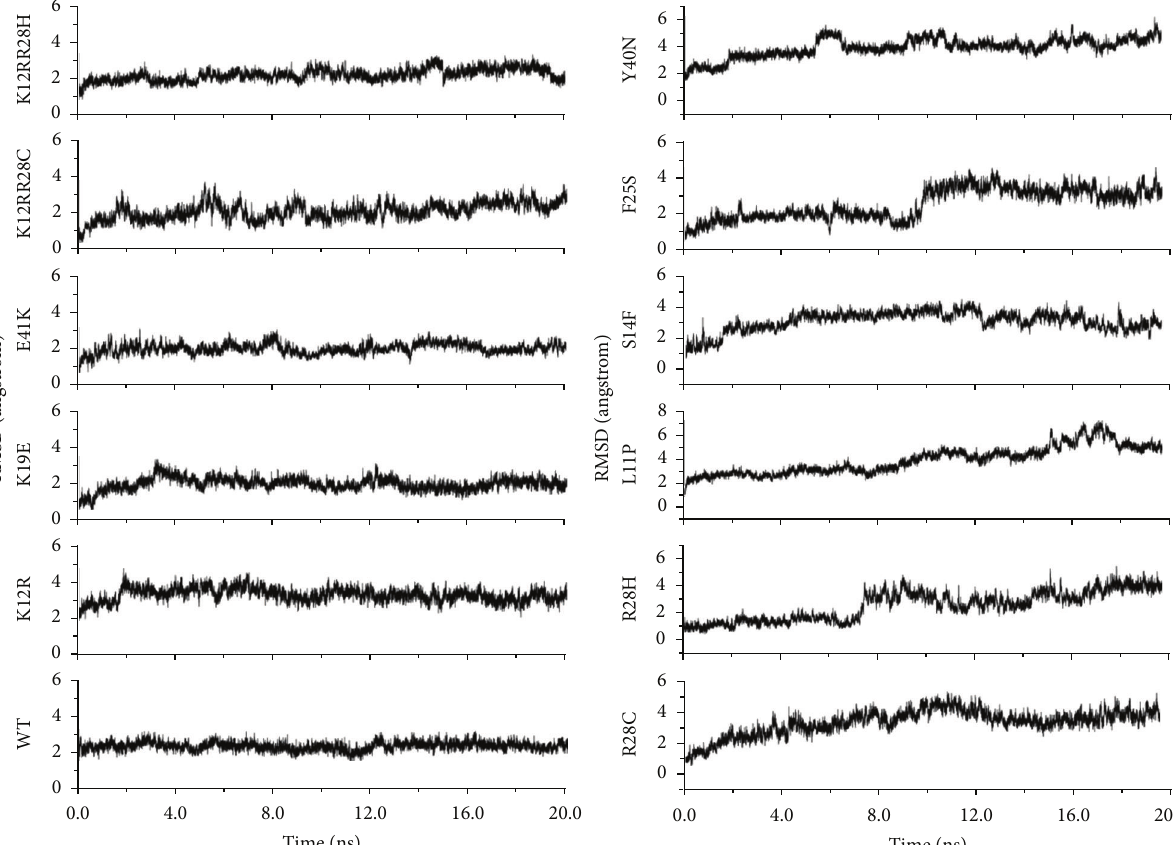
Figure 2: Time dependence of the root-mean-square deviations (RMSDs) for the ligand from its initial structure of 20 ns MD simulations of all complex